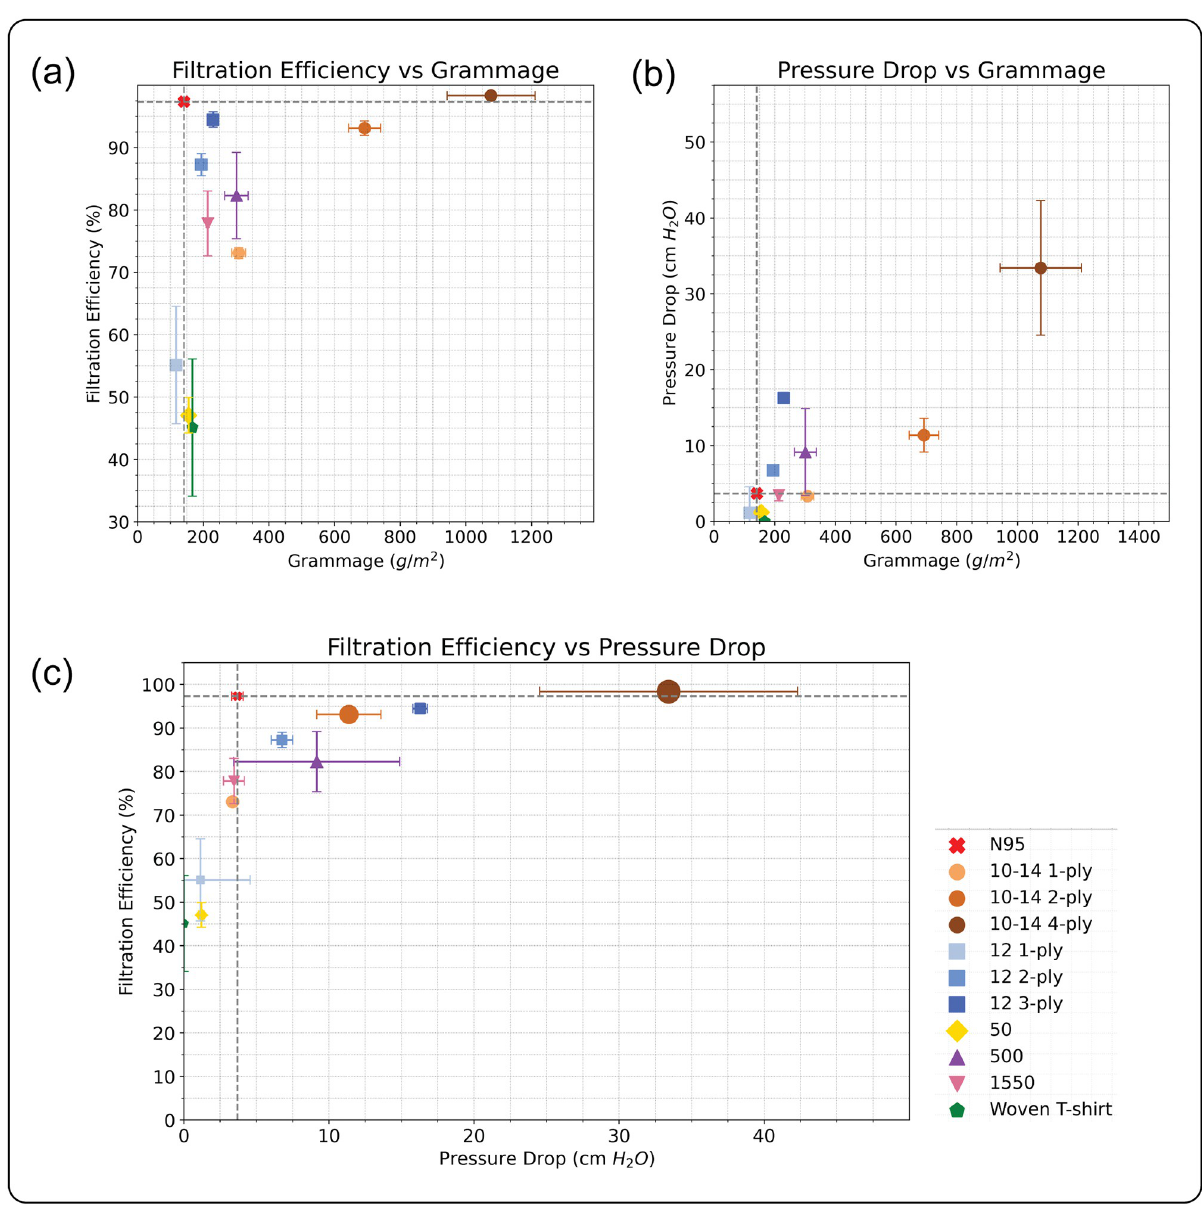
Fig 3. Performance of non-woven filtration media. A: Filtration efficiency and B: pressure drop for several different materials produced via CMS plotted against the grammage of the sample. The numbers in the legend indicate the melt flow indices of the polymers. C: Phase plot of filtration efficiency vs pressure drop with marker size representing grammage of the sample. The markers represent mean reading from N � 3 samples with a triplicate experiment for each sample. The error bars represent standard error of the mean on each side for both vertical and horizontal axes. The dashed lines represent the corresponding measurements for the filter material extracted from N95 FFRs. All the samples were prepared using 30 g of polymer material except for those with explicitly mentioned values of 12 g